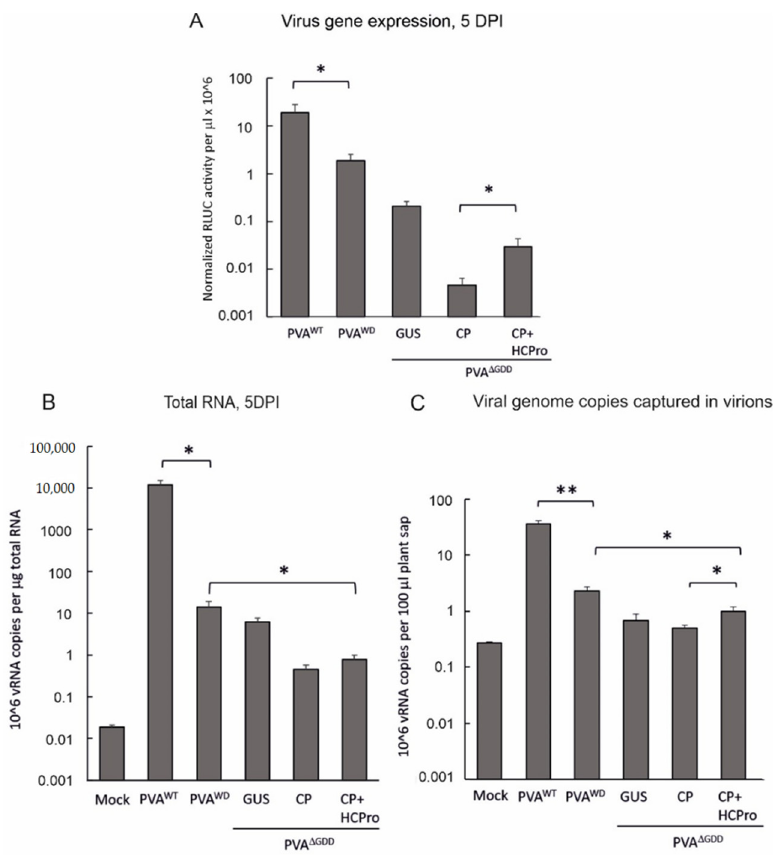
Figure 6. IC-RT-qPCR detects little replication-defective RNA. ( A ) PVA WT and PVA WD alone and PVA ∆ GDD together with either GUS, CP, or CP plus HCPro were transiently expressed in N. bet-hamiana leaves. Gene expression from PVA WT , PVA WD and PVA Δ GDD was quantitated at 5 dpi. The graph is presented in logarithmic scale to accommodate the vast differences in the gene expression amongthe mutant virus infected samples. ( B ) Quantitation of the total genomic vRNA amounts of the same samples as in ( A ). ( C ) Amount of genomic vRNA detected in the same samples as in ( B ) with IC-RT-qPCR indicating the amount of encapsidated PVA RNA. p < 0.01 = **, p < 0.05= *.